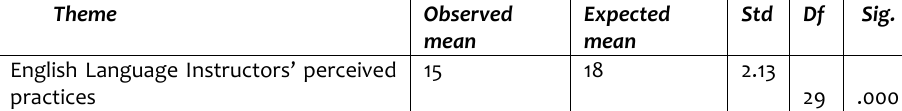
Table 3: Instructors’ perceived practice of English Language reading